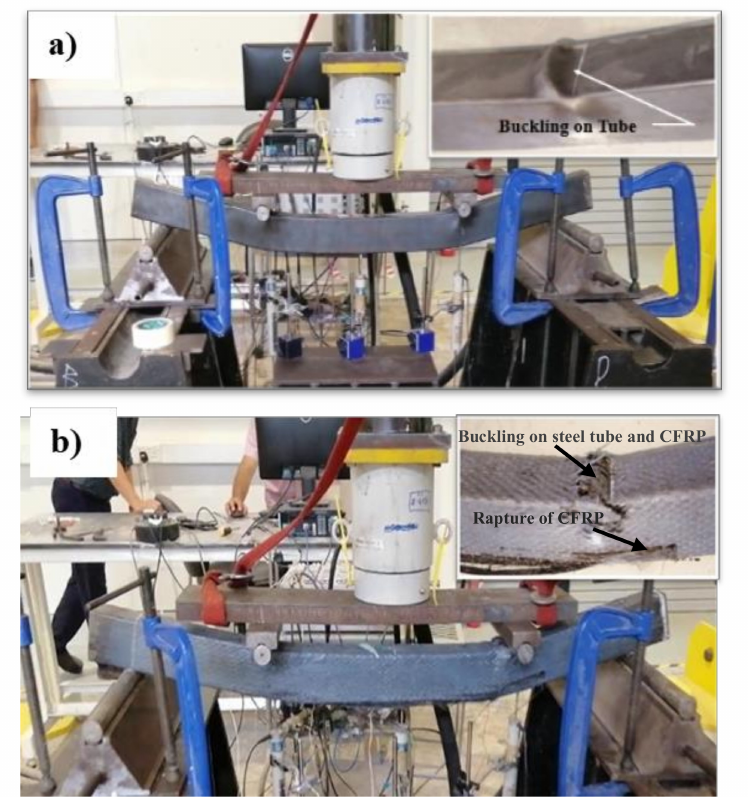
Figure 15. Buckling failure characteristic at the top surface of steel tubes (at the final loading phase); ( a ) B-C and ( b )